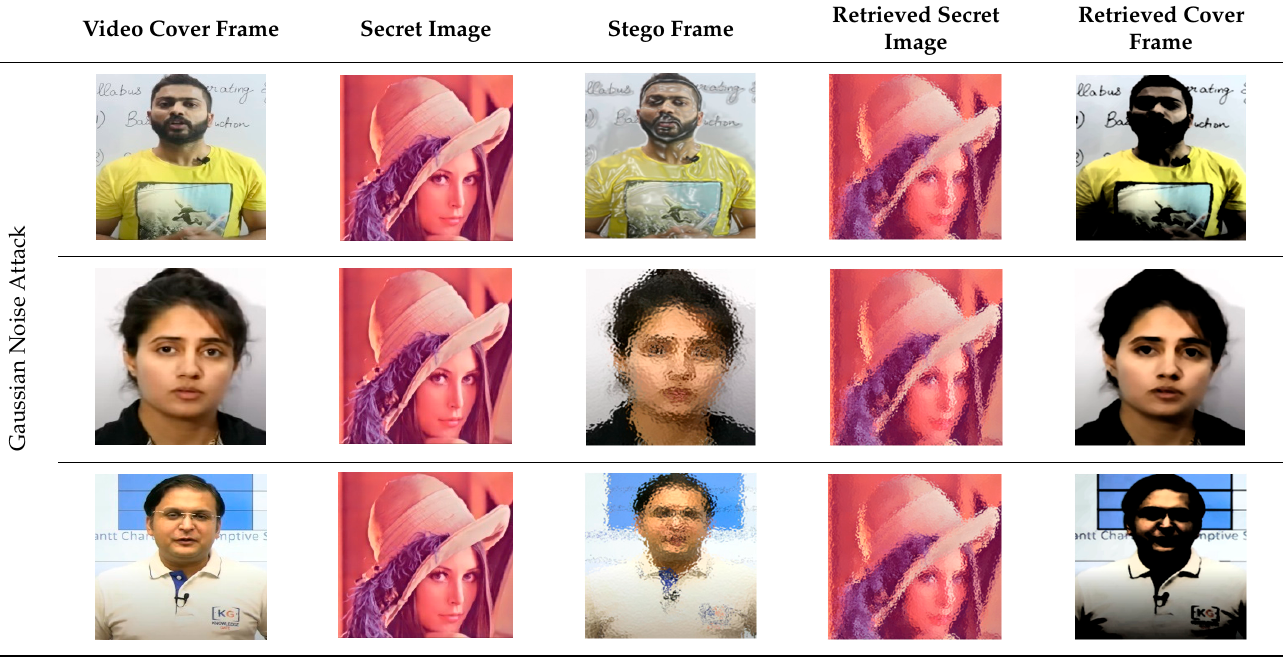
Table 5. Gaussian Noise Attack.